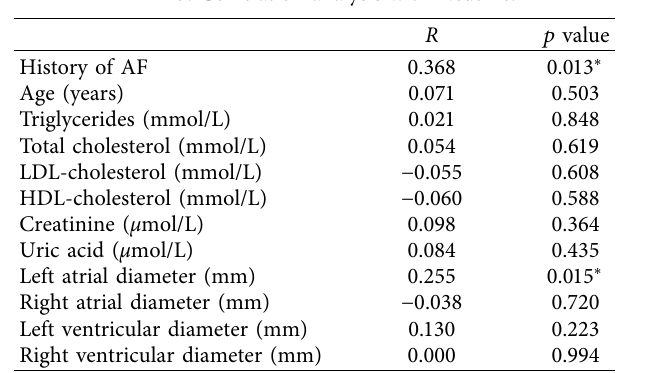
Table 3: Correlation analysis with Neu5Ac.